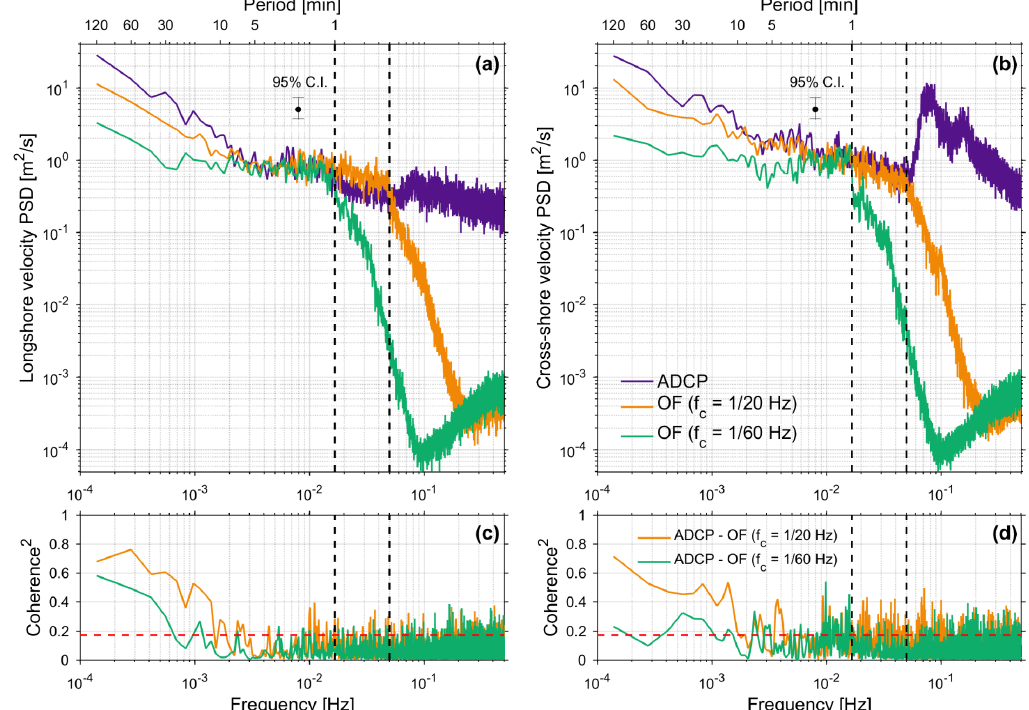
Figure 8. Surface velocity components power spectral density (PSD) and squared coherence computed from the 1-week time series (8 to 15 October 2018) during low tide when the ADCP is located inside the surf zone. ( a ) Longshore and ( b ) cross-shore surface velocity auto-spectra. Squared coherence computed between ADCP and optical flow ( c ) longshore and ( d ) cross-shore surface velocity components along with the 95% confidence bar (red dashed lines). The purple lines indicate the PSDs computed from 1-Hz ADCP surface velocity measurements (average between σ 19 , σ 20 and σ 21 ). The orange and green lines show the PSDs generated from optical flow instantaneous (1 Hz) velocity estimates computed from low-pass filtered images with f c = 1/20 Hz and f c = 1/60 Hz, respectively. Frequencies equal to 1/20 and 1/60 Hz are shown with black dashed